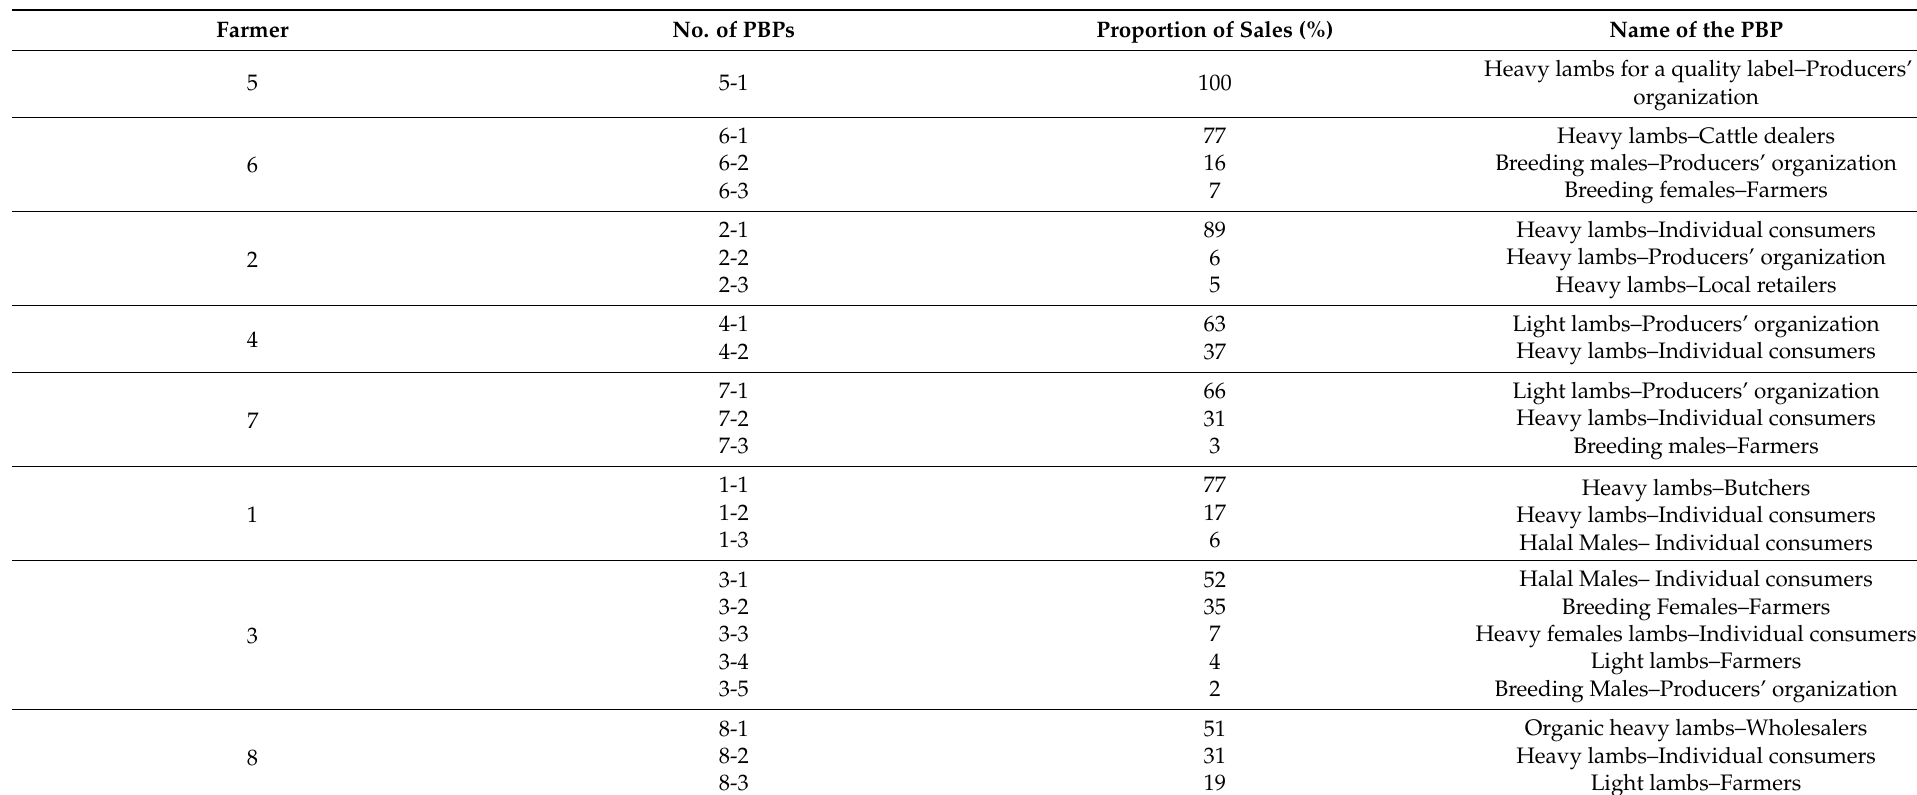
Table 2. Characteristics of the mode of marketing used by the eight sheep meat farmers monitored in this study: for each famer, a set of product–buyer pairs (PBPs).